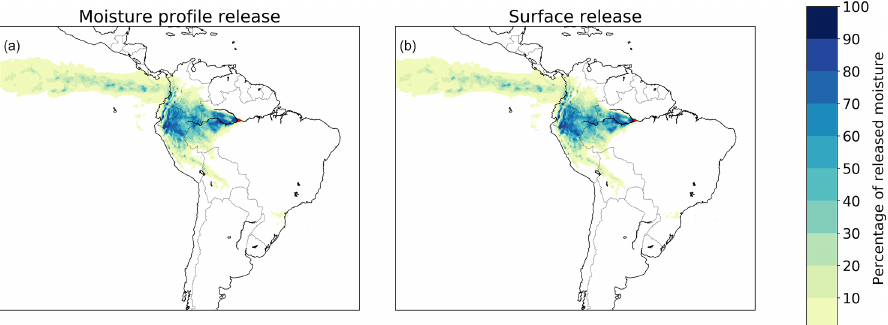
Figure 5. Different footprints of moisture releases from Manaus in July 2012 in a three-dimensional Lagrangian model with moisture released according to the vertical moisture profile of the atmosphere and moisture released at the surface. (a) Release according to the moisture profile, with a mean latitudinal moisture flow of 1.5 ◦ in a northerly direction and mean longitudinal flow of 14.4 ◦ in a westerly direction; (b) release at the surface, with a mean latitudinal moisture flow of 1.3 ◦ in a northerly direction and mean longitudinal flow of 14.2 ◦ in a westerly